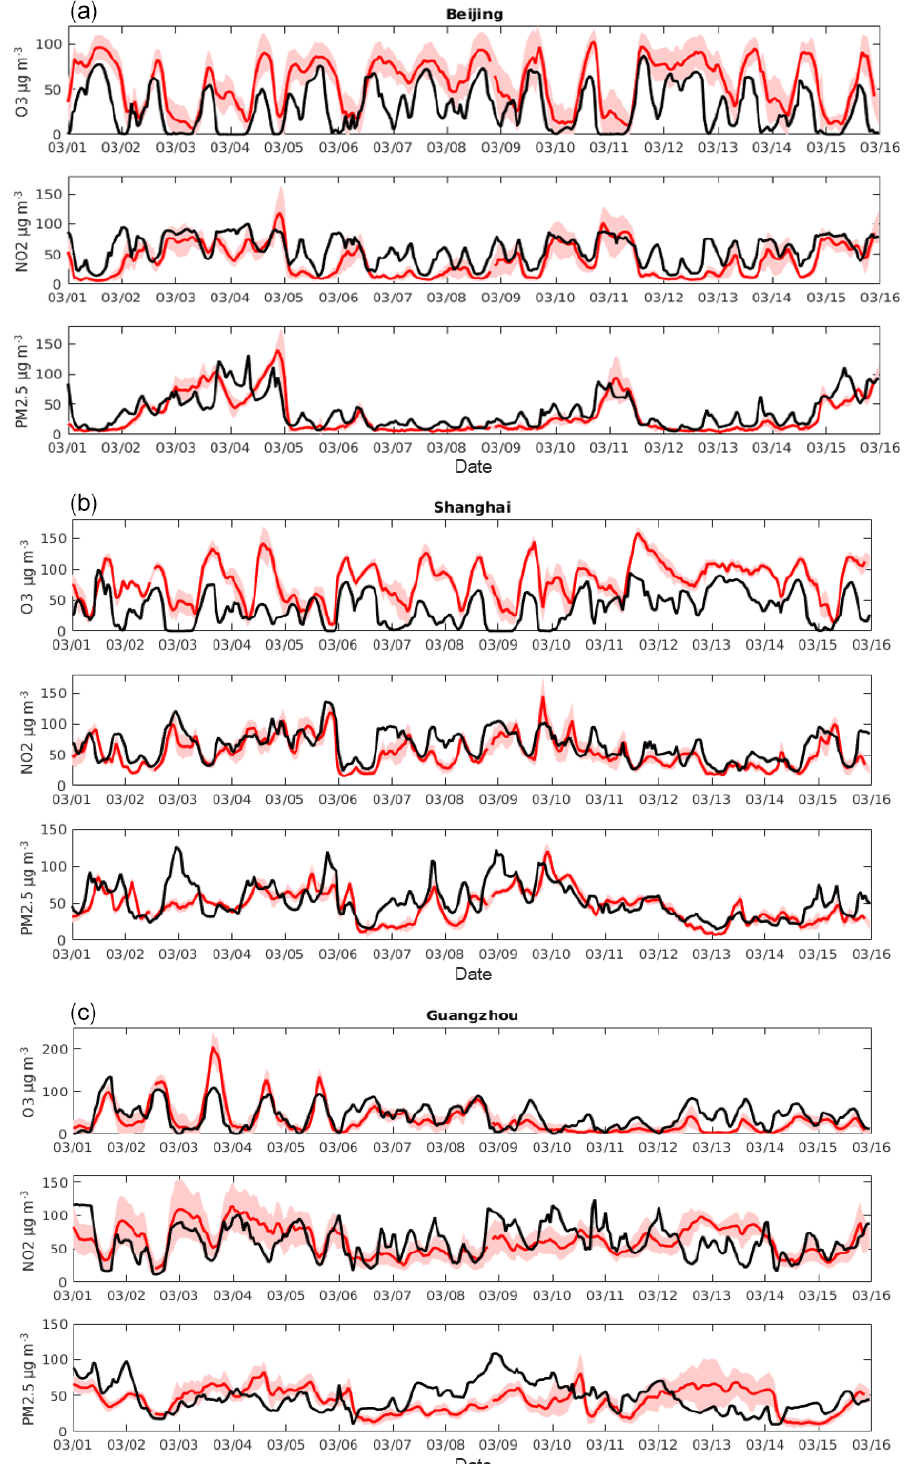
Figure 8. Evolution of the surface concentrations of ozone, nitrogen dioxide, and particulate matter (diameter less than 2.5µm) in (a) Beijing, (b) Shanghai, and (c) Guangzhou between 1 and 15 March 2017. In black: median of calculated values by the different models; in red: observed median